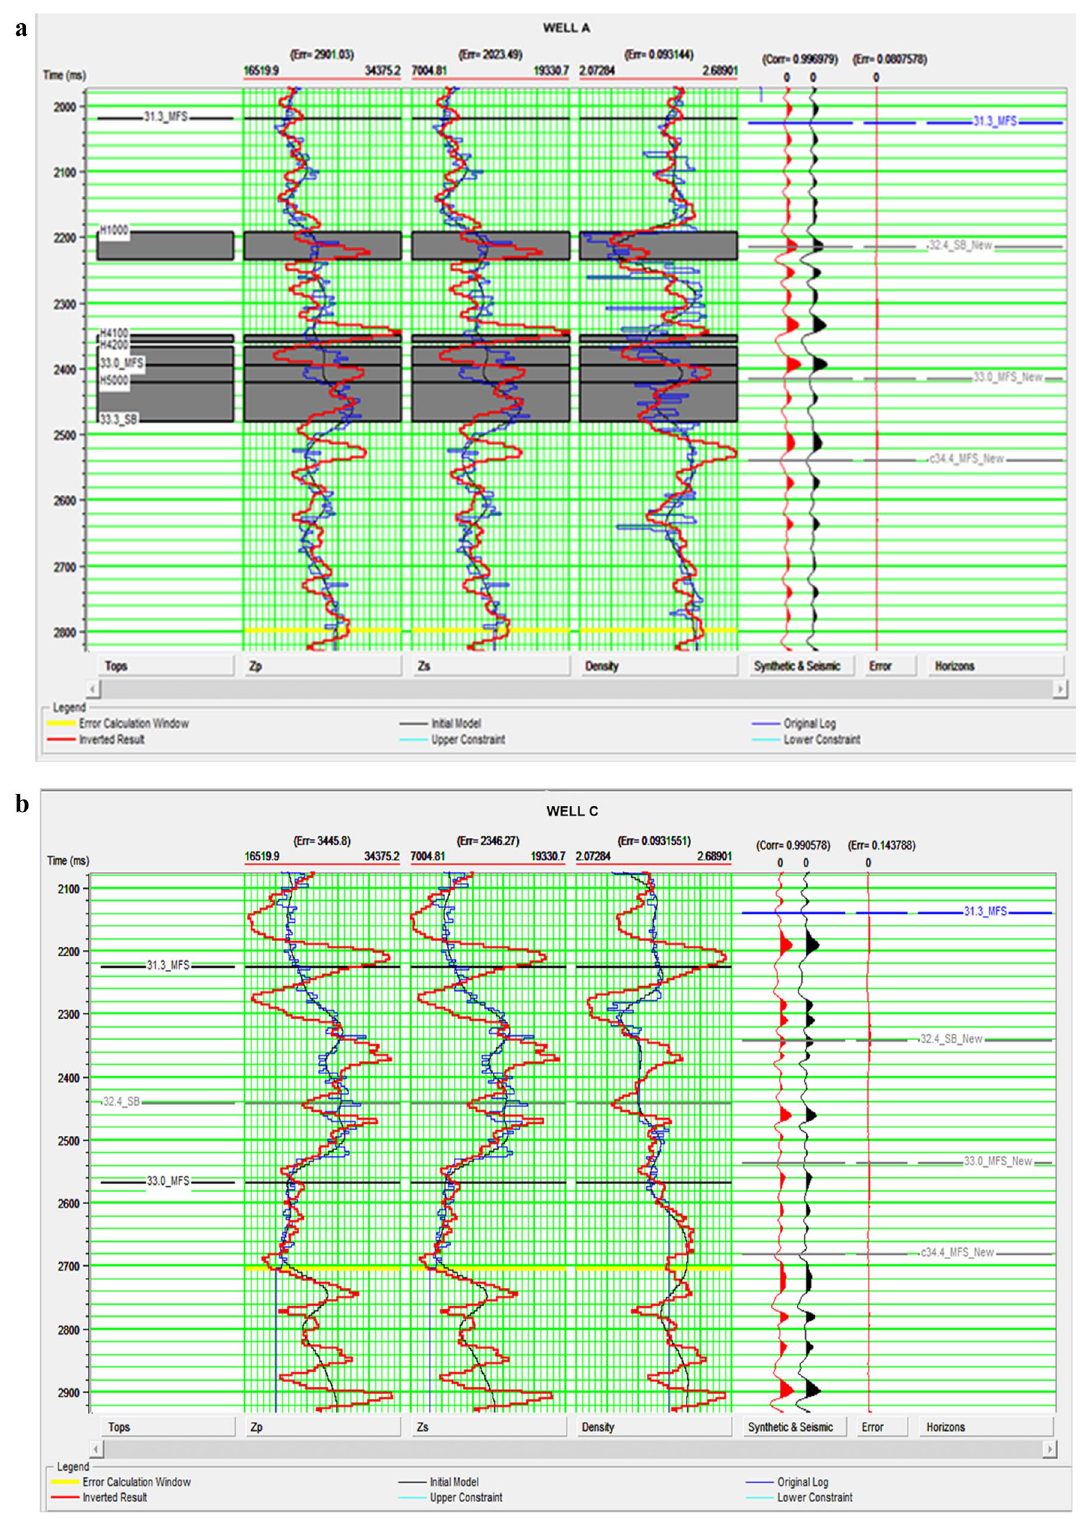
Fig. 8 a Inversion analysis result showing correlation value of 0.996979 with synthetic, seismic and picked horizons after seismic upscaling in well A. b Inversion analysis result showing correlation